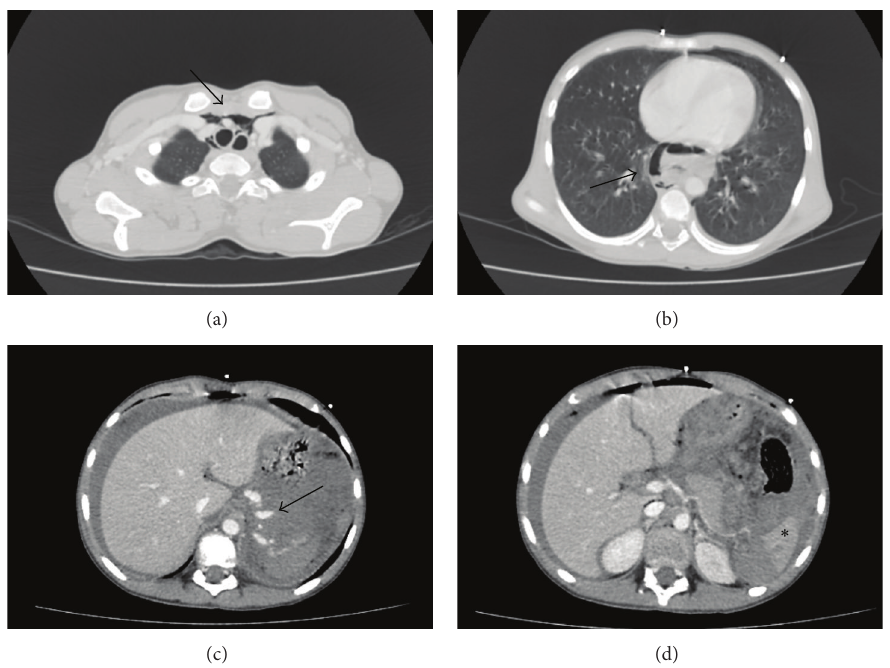
Figure 1: Thoracoabdominal emergency computerized tomography. (a) and (b) Mediastinal massive free air (arrows). (c) and (d) Laceration of the spleen (asterisk), massive intra-abdominal free fluid with free air, and active intraperitoneal bleeding